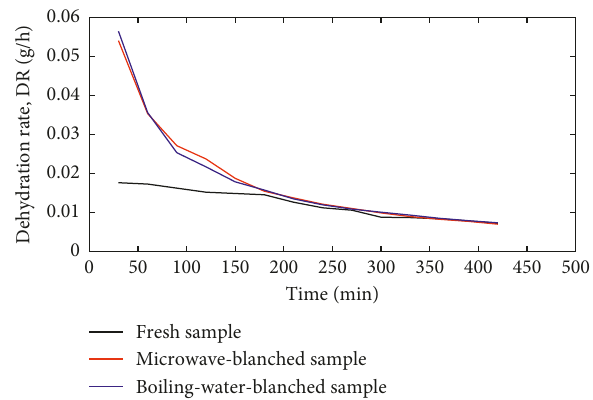
Figure 6: Effect of blanching pretreatment on the dehydration rate of pomegranate seeds ( C sample/solution weight ratio Table 2: Solute and water effective diffusivities during OD. Sample